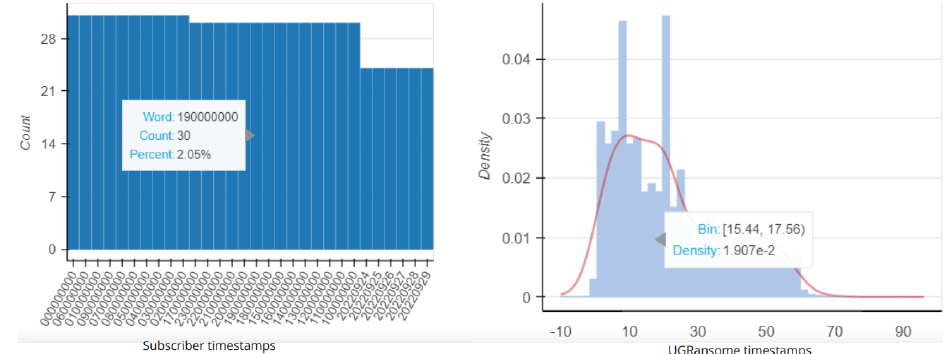
Figure 14. The timestamp and density